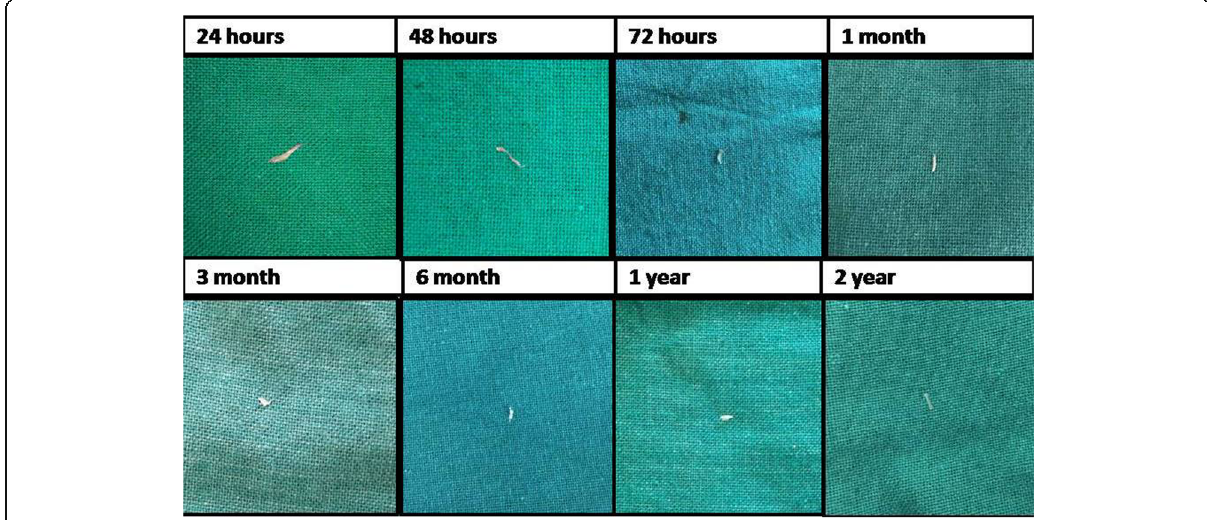
Fig. 2 Morphologic characteristics of the pulp tissue at various post-mortem time intervals